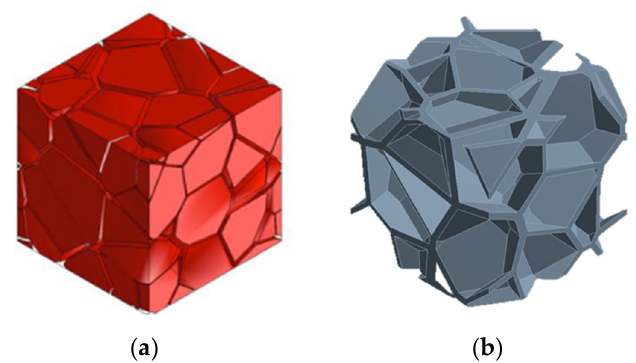
Figure 5. Voronoi Unit Cell. ( a ) grains and ( b ) grain boundaries.